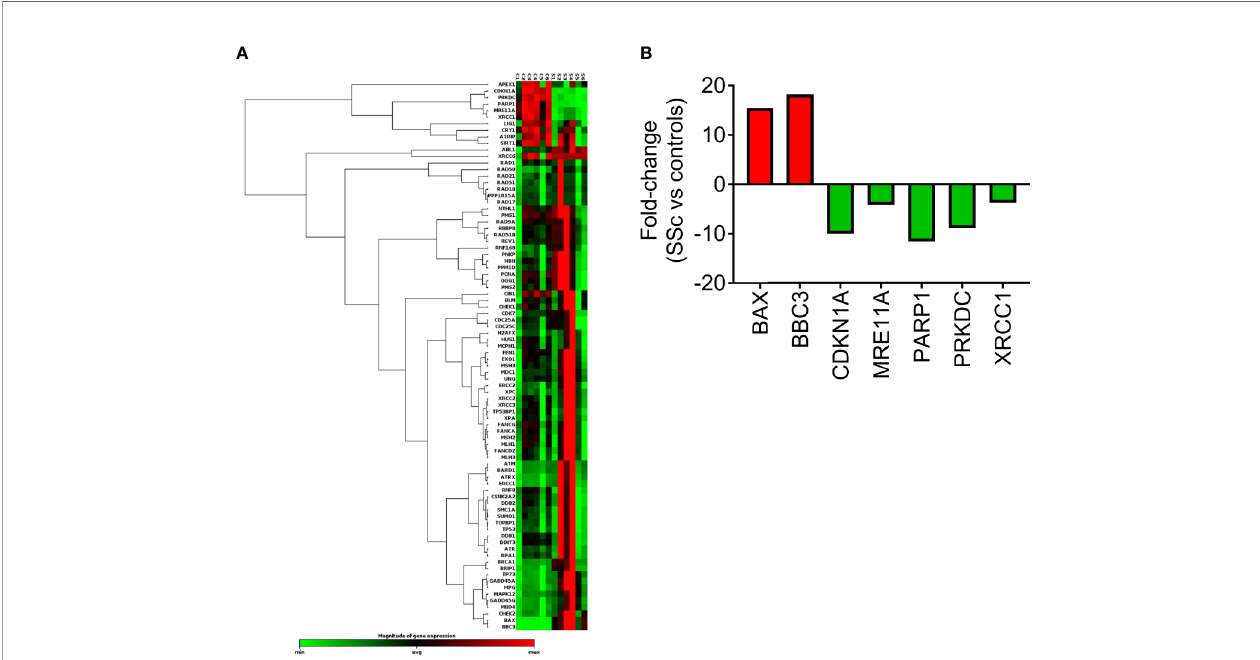
FIGURE 3 | Transcriptional pro fi ling of central DDR/R-associated genes. (A) Hierarchical clustergram of 84 DDR/R-associated genes in untreated PBMCs from 6 HCs and 6 SSc patients. (B) Genes demonstrating at least 2-fold difference in the transcript levels between SSc patients and HC. Gene acronyms are explained in Supplementary Table 2 .